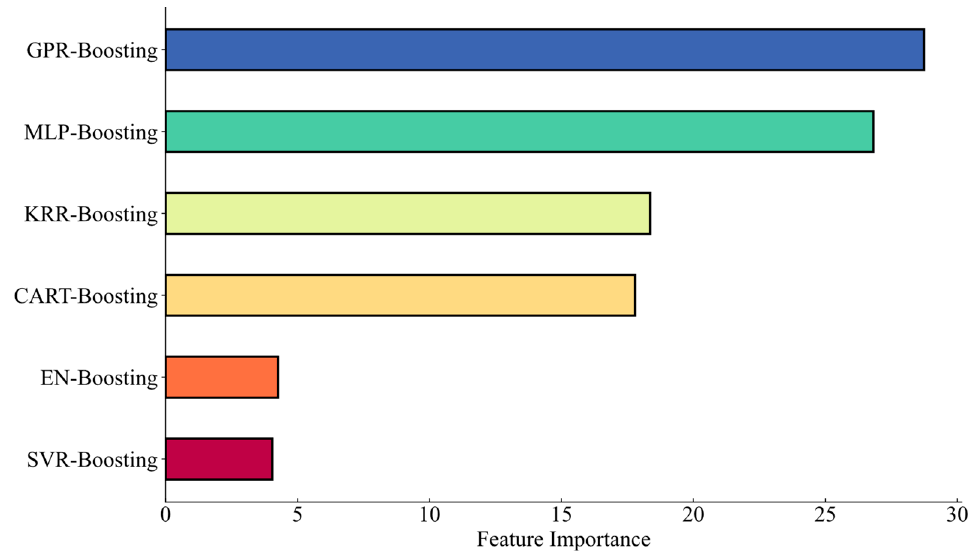
Figure 11. Feature importance.